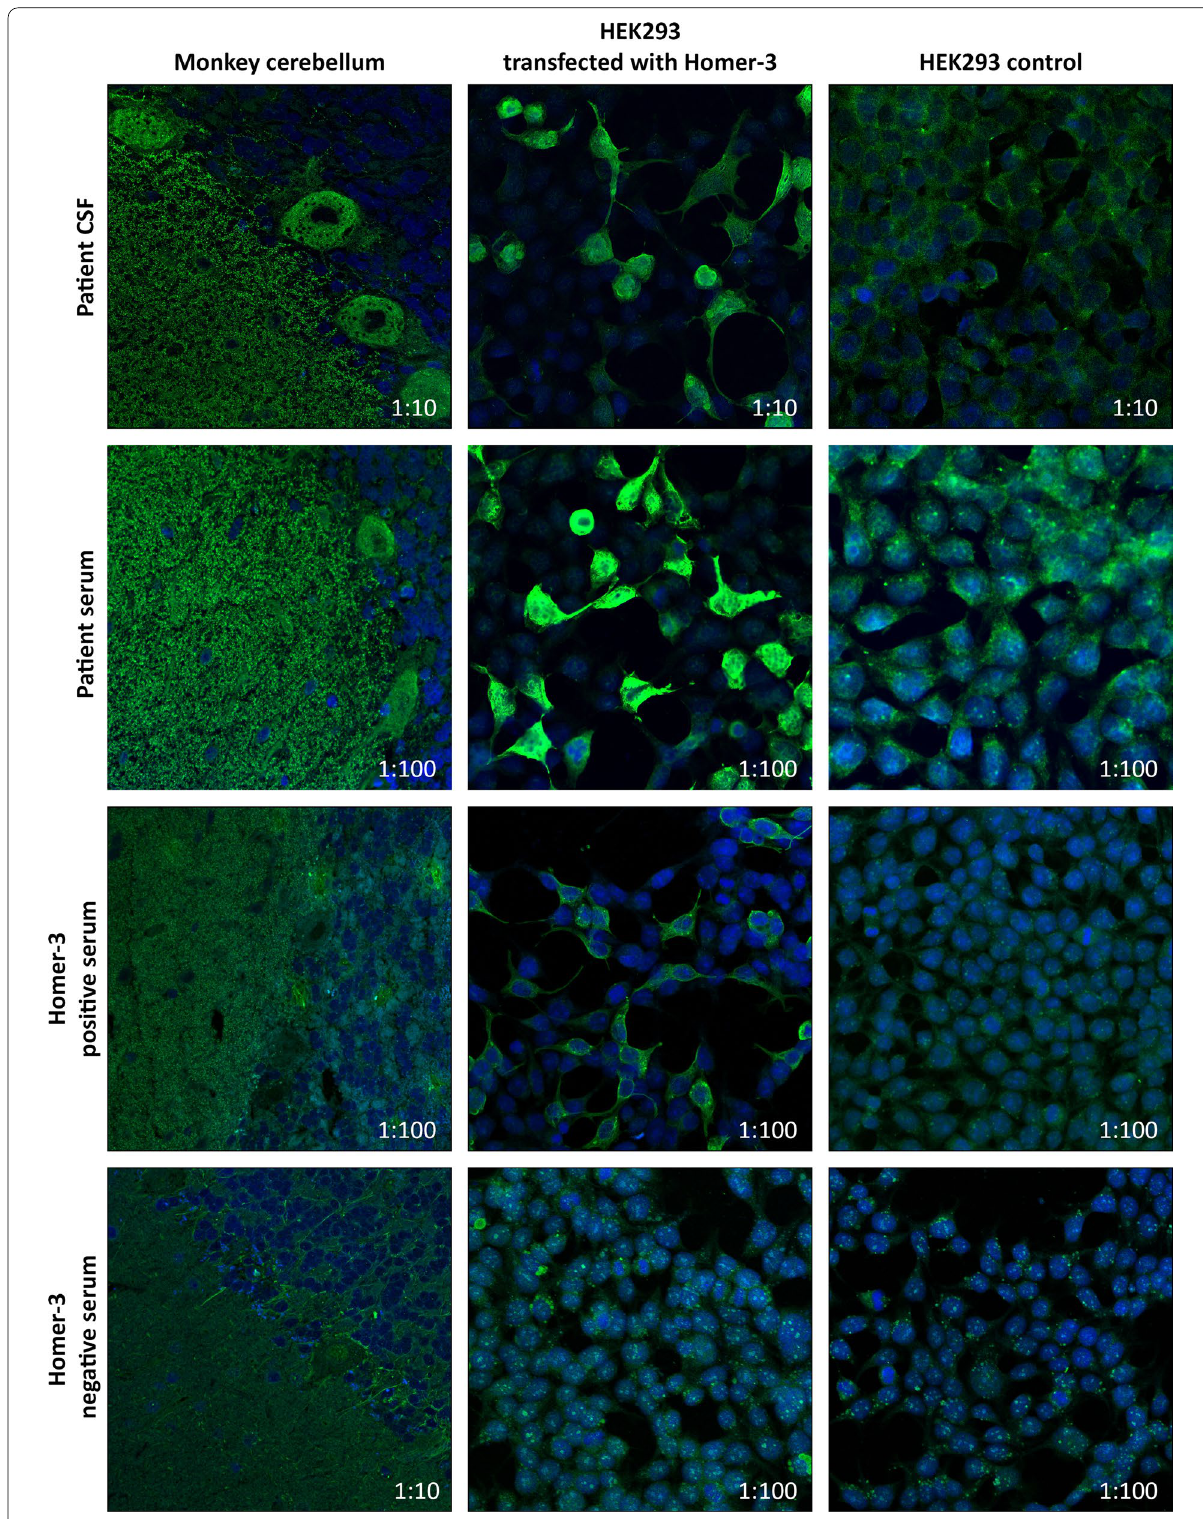
Fig. 1 Immunofluorescence analysis of the patient’s samples (rows 1 and 2), as well as two additional samples from two other patients, known to be positive (row 3) or negative (row 4) for anti-Homer-3 antibodies. Numbers in figure panels indicate respective dilution of samples. HEK293 controls were included for all incubated samples (right column) and did not show